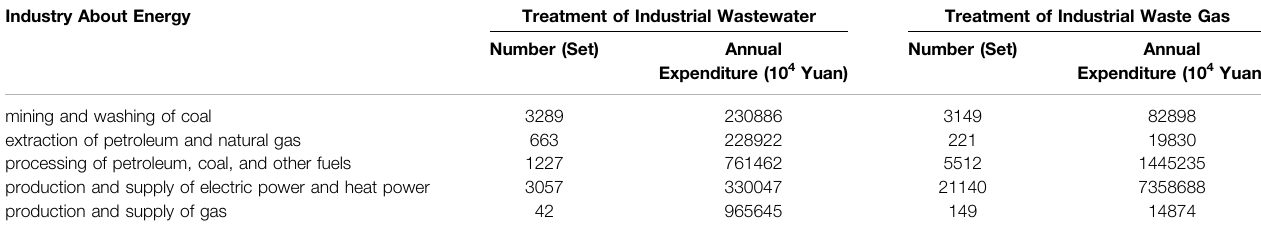
TABLE 4 | Number and annual expenditure of industrial waste-water and waste gas treatment facilities in some industries about energy in China 2019. Industry About Energy